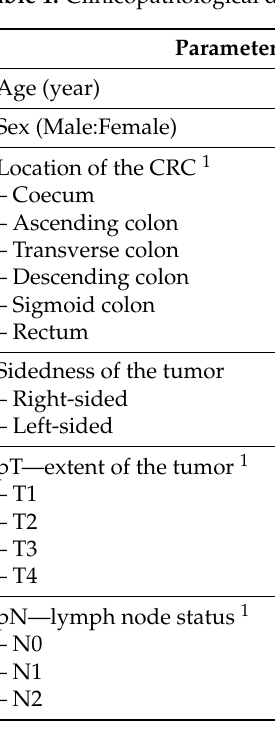
Table 1. Clinicopathological description of study